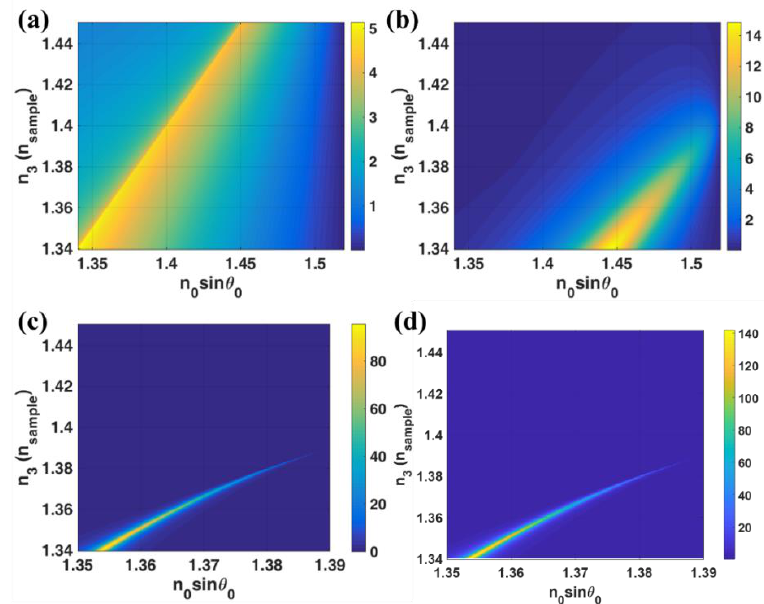
Figure 10. |t p | 2 responses when the sample refractive index n 3 changed from 1.34 to 1.45. ( a ) n 0 = n 1 = n 2 = 1.52, and varying n 3 ; ( b ) n 0 = n 1 = 1.52, n 2 = 0.18344 + 3.4332 i with d 2 = 48 nm and varying n 3 ; ( c ) n 0 = 1.52, n 1 = 1.34 with d 1 = 930 nm, n 2 = 0.18344 + 3.4332 i with d 2 = 20 nm and varying n 3 and ( d ) n 0 = 1.70, n 1 = 1.34 with d 1 = 930 nm, n 2 = 0.18344 + 3.4332 i with d 2 = 20 nm and varying n 3 .